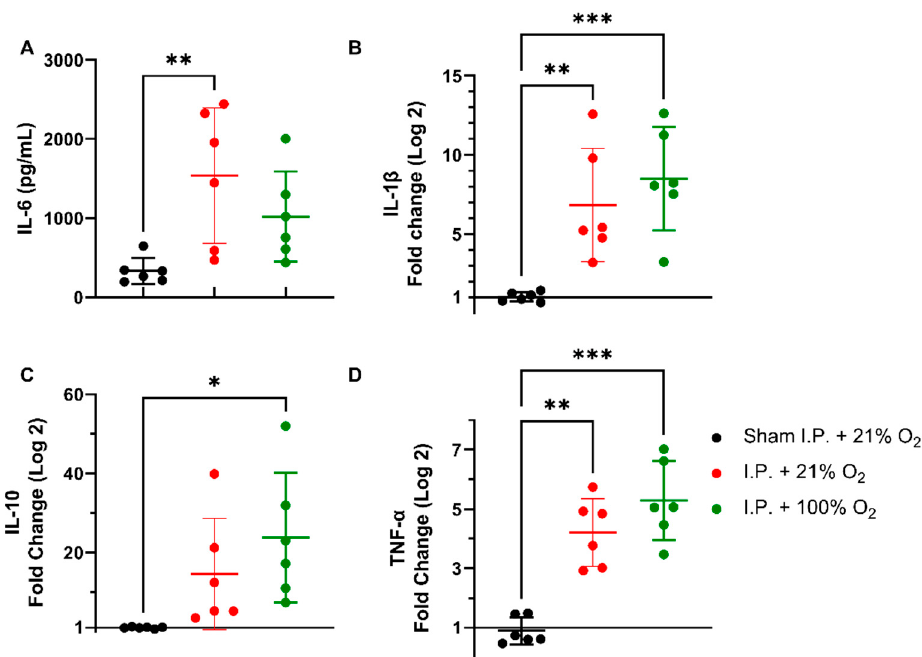
Figure 4. Inflammatory changes in systemic IL-6 ( A ) and intestinal IL-1 β ( B ), IL-10 ( C ), and TNF- α ( D ) due to oxygen supplementation were assessed. ( n = 6/group). IL: interleukin; I.P.: intraperitoneal injection anesthesia; O2: oxygen; TNF- α : tumor necrosis factor—alfa. * p < 0.05; ** p < 0.01; *** p <